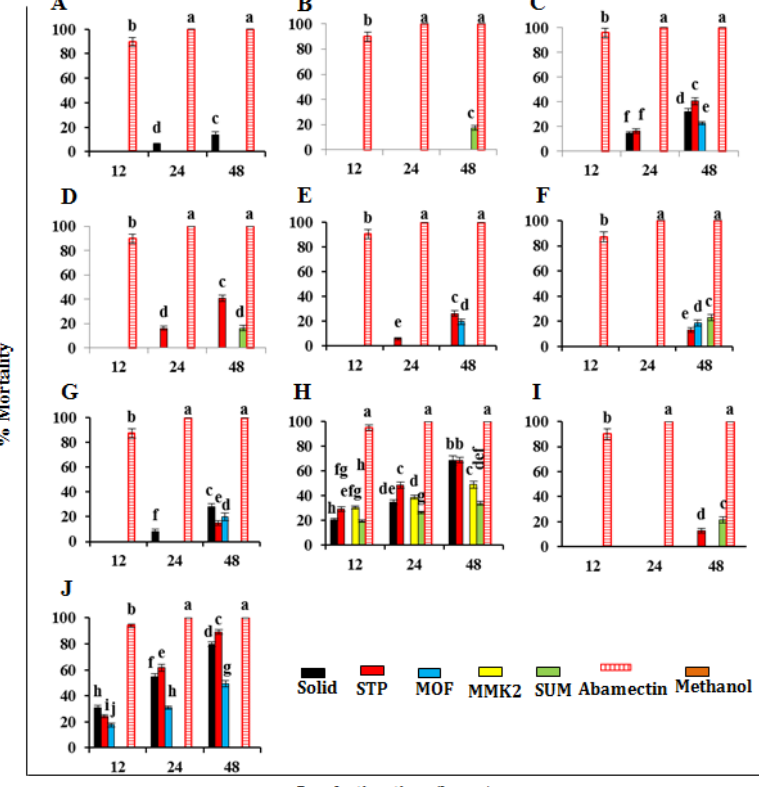
Figure 5. Effect of SMs of Trichoderma spp. obtained on different growth media on M. incognita juveniles (J2s) mortality of M. incognita . Values are the mean of three replicates. ( A ) T. pseudoharzianum (T113); ( B ) T. koningiopsis (T84); ( C ) T. asperelloides (T136); ( D ) T. pseudoharzianum (T129); ( E ) T. pseudoharzianum (T160); ( F ) T. afroharzianum (32233); ( G ) T. acitrinoviride (T130); ( H ) T. hamatum (T21); ( I ) T. afroharzianum (T52); ( J ) T. viridae . The bar represents the mean with standard deviation. Missing columns for some treatments indicated their 0.0% mortality (or no activity). Treatments having similar lettering on the bar chart show no significant ( p ≥ 0.05) di ff erence according to Fisher’s protected LSD